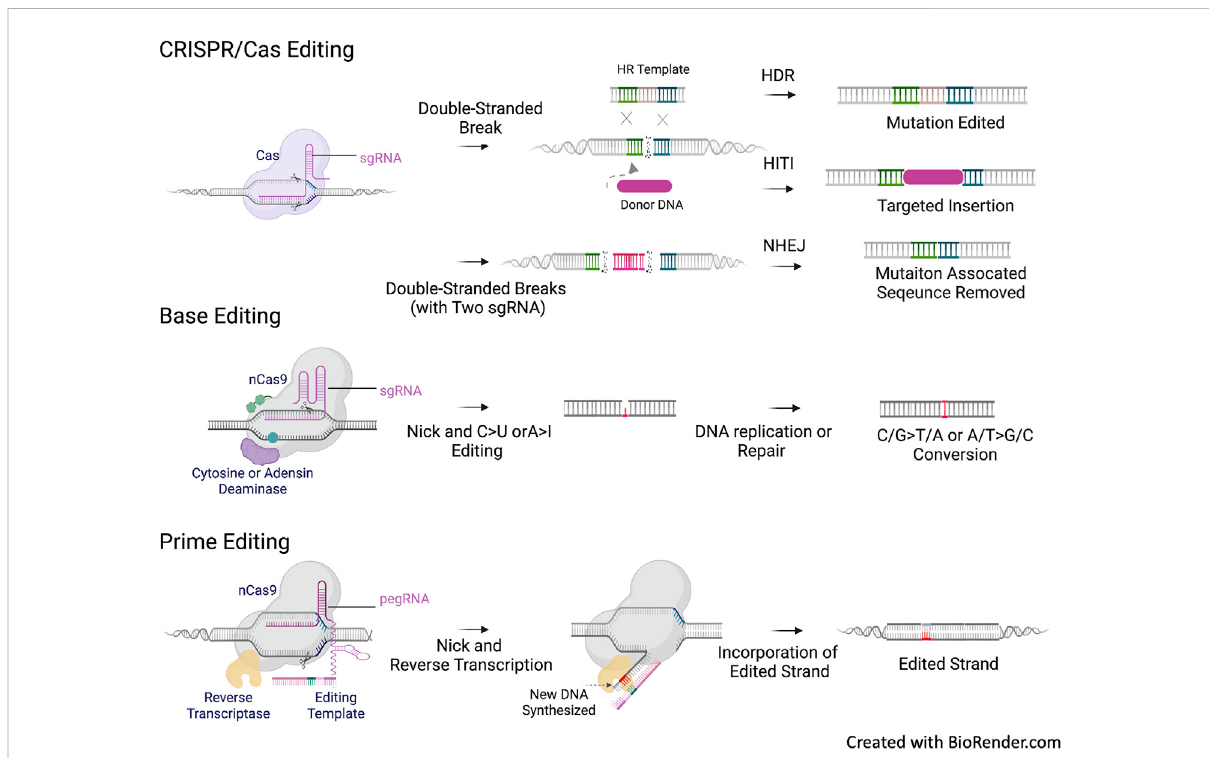
FIGURE 3 CFTR mutation types and CREIPSR-based Gene Editing. CRIPSR/Cas editing approaches rely on the generation of double stranded DNA break (DSB) andthefollowingrepair via non-homologous endjoining(NHEJ) orhomologousrecombination (HR).NHEJcanbeused for theallelespeci fi c repair of splicing mutation in the intronic sequence, such as the 3272-26A > G (c.3140 – 26A > G) and 3,849 + 10kbC > T (c.3718 – 2477C > T) CFTR mutations. Homology-independent targetedinsertion (HITI)isanapproach basedonNHEJ.Theoretically,HITI canuniversallyaddressall CFTR variants independent of genotypes, the donor DNA can be a splicing acceptor associated CFTR cDNA sequence to be inserted into the intronic sequence of CFTR to reconstitute a mutation free mini gene, or a CFTR expression cassette to be inserted into the safe harbor of the chromosome, such as AAVS1. Homology-directed repair (HDR) requires a template for HR to correct point mutation or small deletion/deletion. Base editing and prime editing do not require thegeneration of DSB and DNA template for correction. Base editing is onlyused to correct single base point